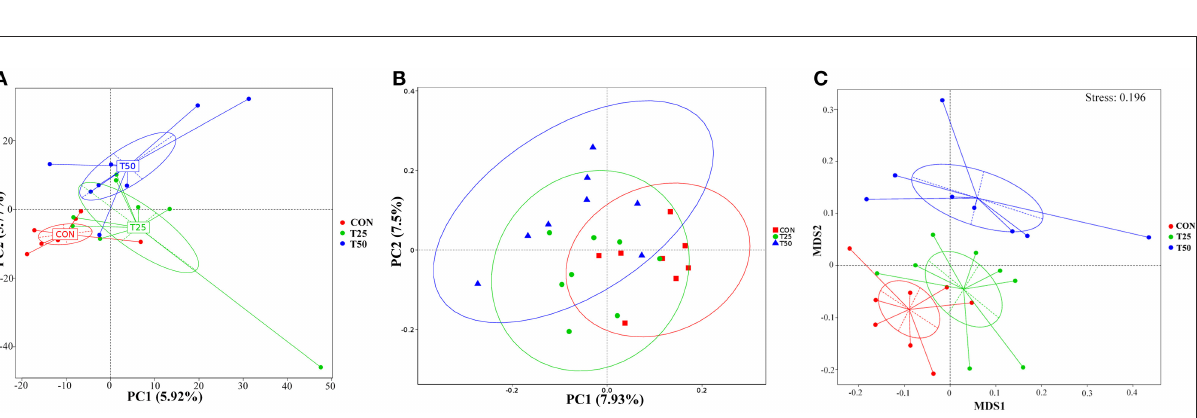
FIGURE6 Differences of bacteria between groups. (A) PCA main coordinate axis analysis; (B) PCoA main coordinate axis analysis; (C) NMDS nonmetric multidimensional scale analysis.